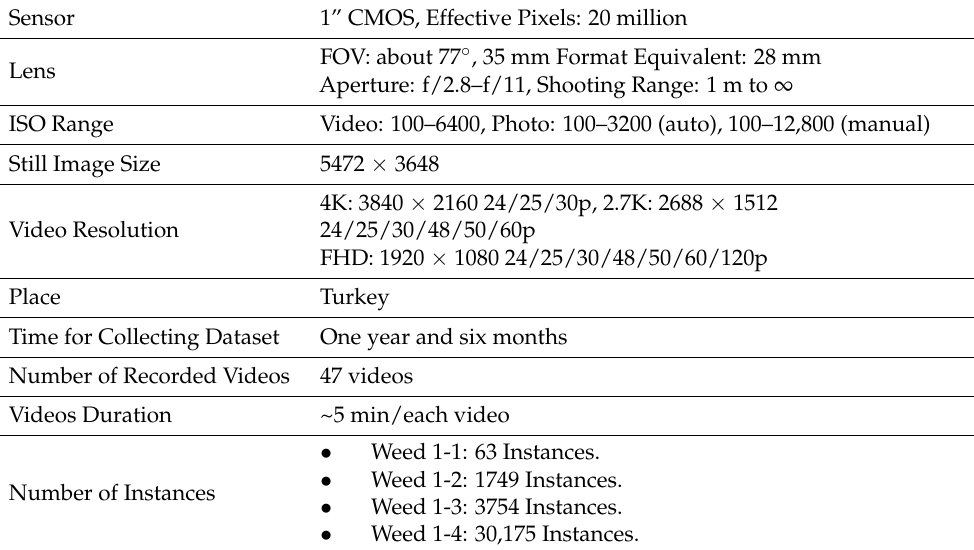
Table 4. UAV camera features and collected dataset